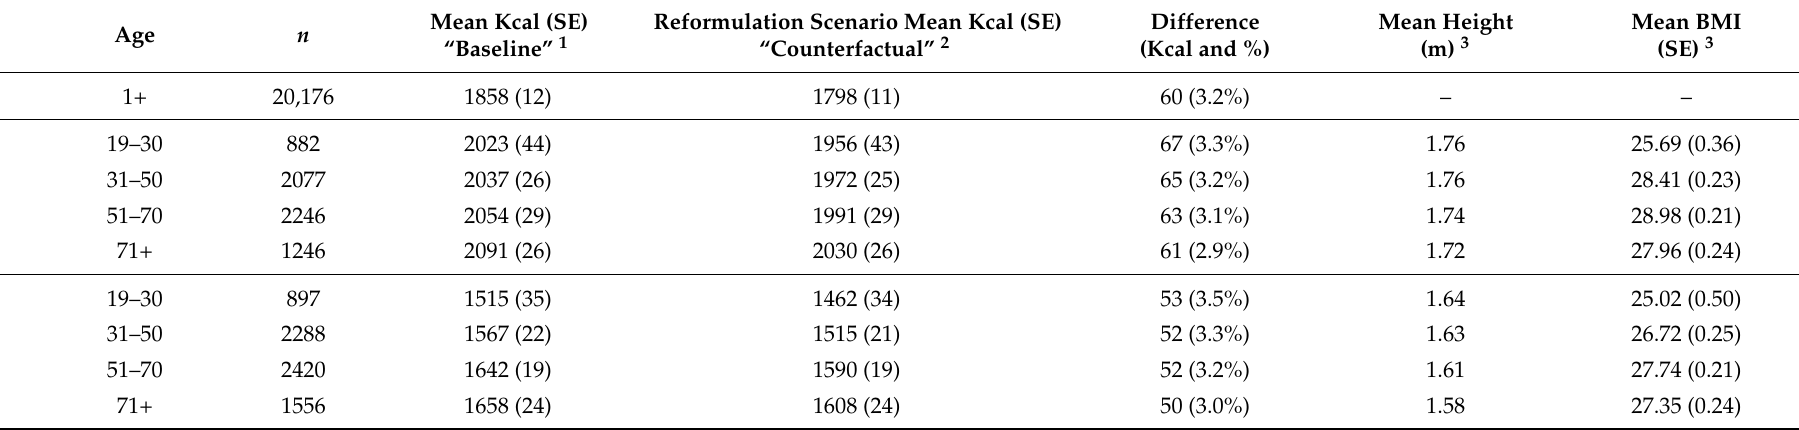
Table 1. Mean calorie intake (kcal/day) for baseline and reformulation scenario (a systematic reduction in free sugars content in packaged foods and beverages by